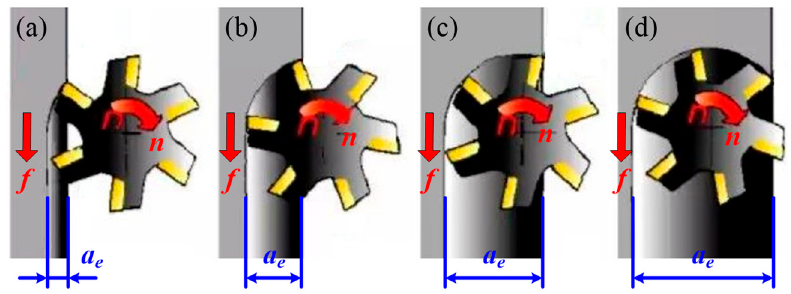
Figure 1. Schematic diagram of asymmetric milling with the radial depth of cut increasing from small ( a , b ) to large ( c , d ). small ( a , b ) to large ( c , d